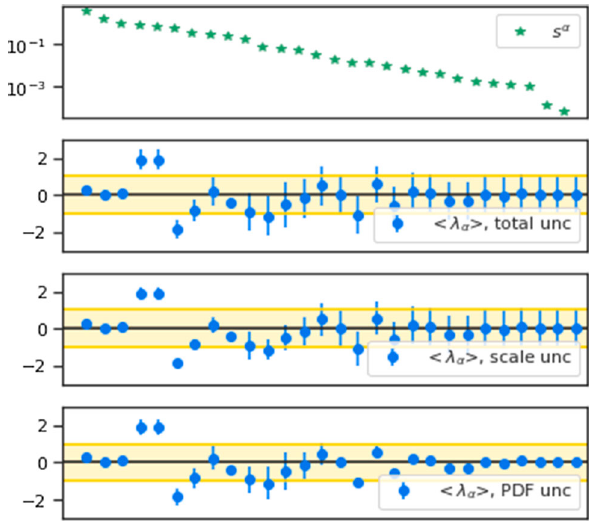
Fig. 4 The 28 positive eigenvalues s α of the theory uncertainty matrix S ij (above), shown in descending order, and 28 nuisance parame- ters λ α corresponding to the 28 eigenvectors β α (below), as given by Eq. (4.18).The uncertainties in the nuisance parameters are shown in total(squarerootsofthediagonalentriesofEq.(4.20),andbrokendown into the contribution from scale uncertainties alone (square roots of the diagonal entries of Eq. (4.11) and from PDF uncertainties (square roots of the diagonal entries of the last term in Eq. (4.20). The yellow bands highlight the region between ±